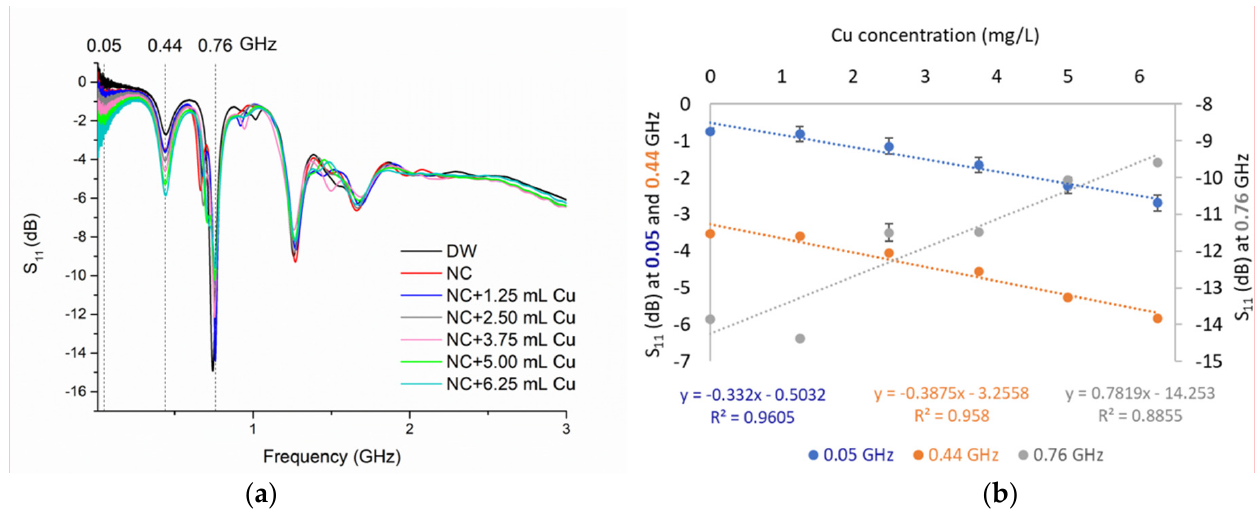
Figure 9. ( a ) Microwave spectral response between 0.01 and 3 GHz for a collected water sample (NC) spiked with standard Cu addition with highlighted (dash lines) resonant frequencies at 0.05, 0.44 and 0.76 GHz; ( b ) linear correlations between the increase in Cu and change in S 11 response at the three resonant frequencies. Between them, the peak located at 0.44 GHz was selected for its higher linear correla- tion (R 2 > 0.96), higher sensitivity (0.38 dB for each 1 mg/L variation in Cu